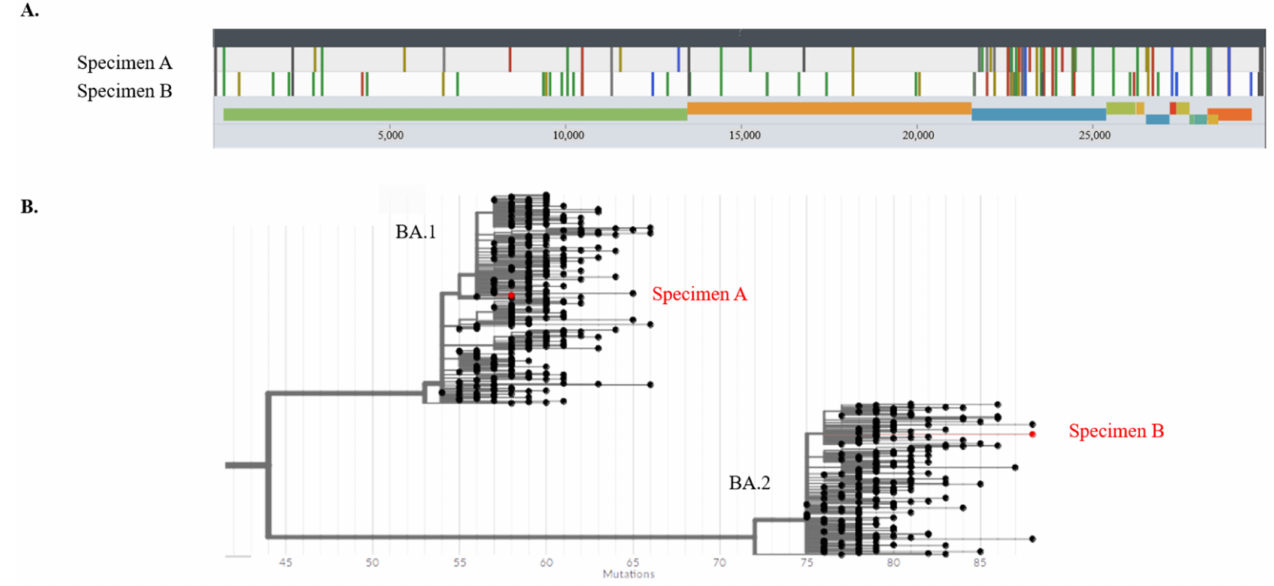
Figure 4. ( A ). Base variation plots of SARS-CoV-2 strains of the first (specimen A) and second (specimen B) coronavirus disease infections against the reference genome ( B ). A phylogenetic tree of Omicron BA.1 and BA.2 strains with specimens A and B generated by UShER. The phylogenetic tree is rooted at the Wuhan-Hu-1 reference and the numbers at the bottom indicate the base difference from the reference genome. Table 1. Characteristic base variations, taken from pangolin version 4.1.1 data, for BA.1-like and BA.2-like strains, and their presence or absence in specimens A and